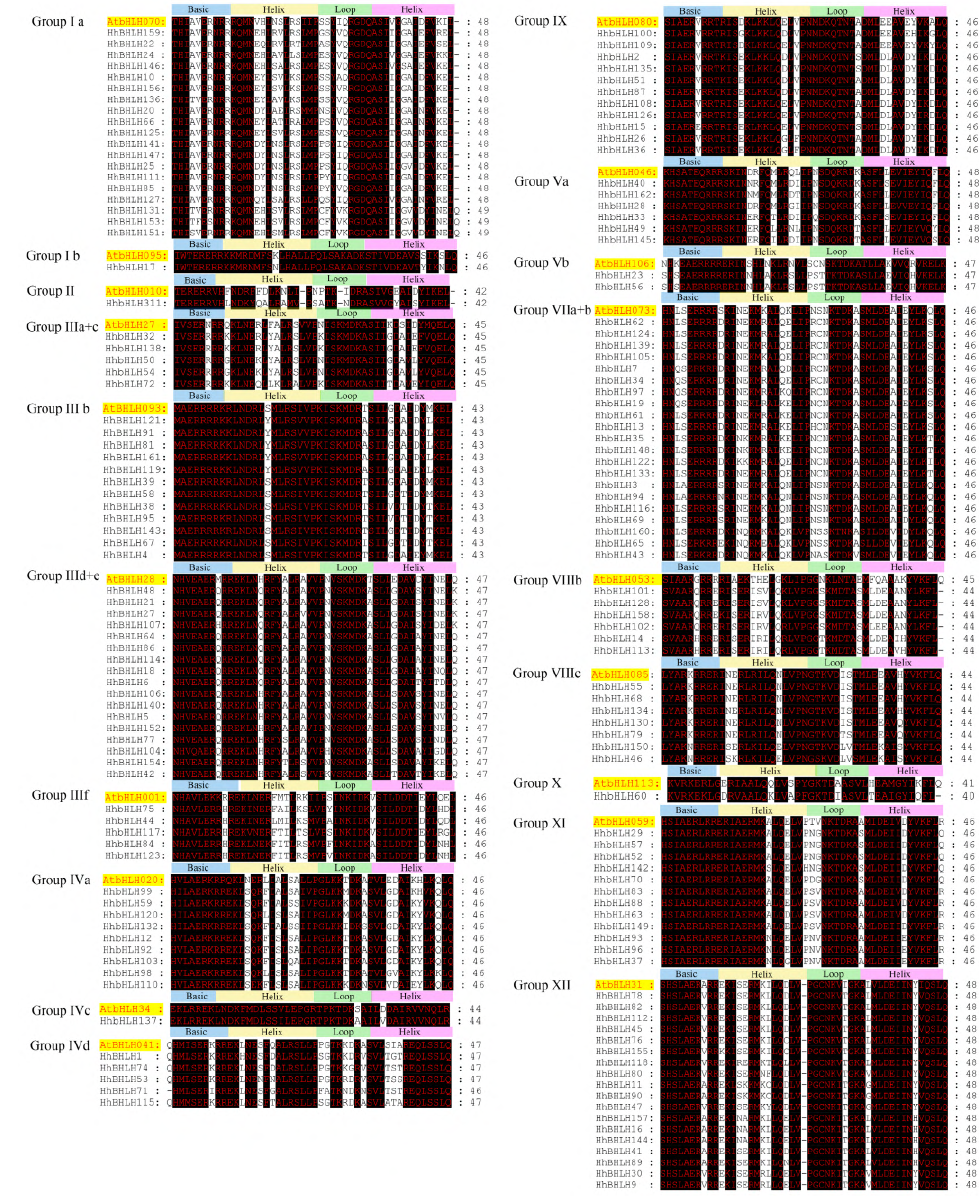
Figure 1. Alignment of the amino acid sequences of multiple HhbHLH and selected Atb HLH domains. We studied and drew the unrooted phylogenetic tree applying the neighbor-joining (NJ) method based on the similarities between Arabidopsis and H. hamabo bHLH domains. The result revealed that the 162 HhbHLHs gene can be classified into 19 distinct clades. Among them, the VIIa+b subfamily had the most members (20 HhbHLHs ), whereas Groups Ib, II, IVc, and X subfamily had the fewest members (one HhbHLH ). In addition, the H. hamabo bHLH subfamily was extended or contracted to different degrees in comparison with Arabidopsis . The VIIa+b subfamily of Arabidopsis , for example, had 15 members, which grew to 20 in H. hamabo . In subfamilies Ia and Iva, a similar condition existed, while in the X subfamily there was a substantial reduction in the number of H. hamabo genes, from nine to one in Arabidopsis (Figure